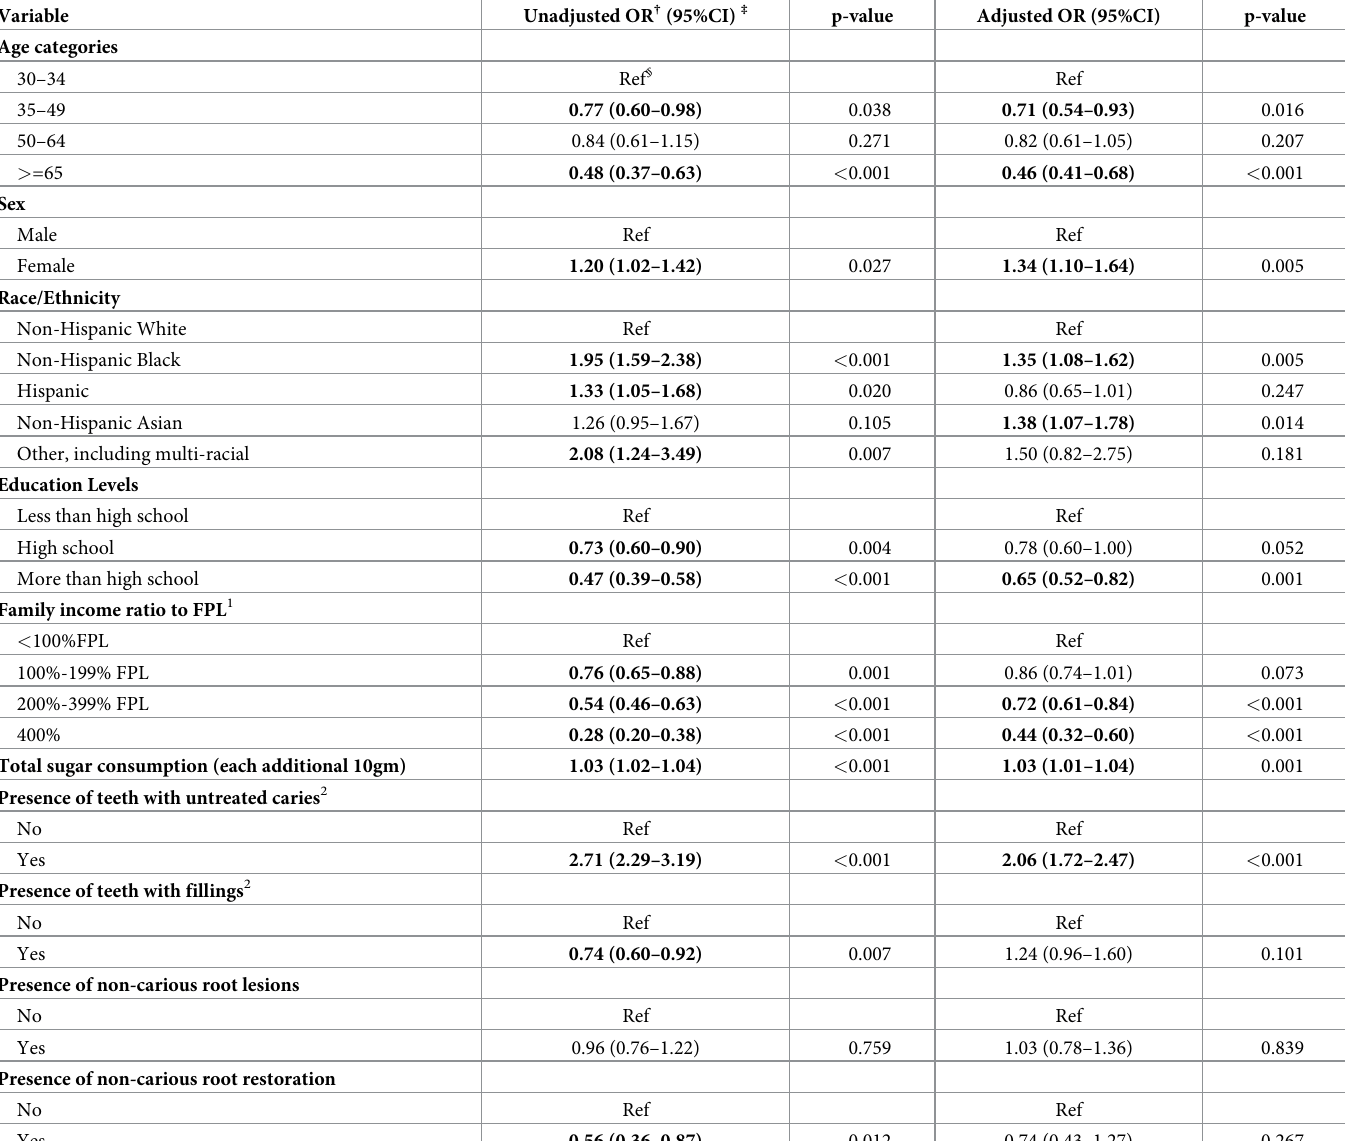
Table 2. Logistic regression models of associations between oral pain experience last year and individual characteristics among adults aged � 30 years who com- pleted the dental examination and at least the first 24-hour dietary recall interview, had at least one natural tooth, and provided an answer about their oral pain experience in the National Health and Nutrition and Examination Survey (NHANES);